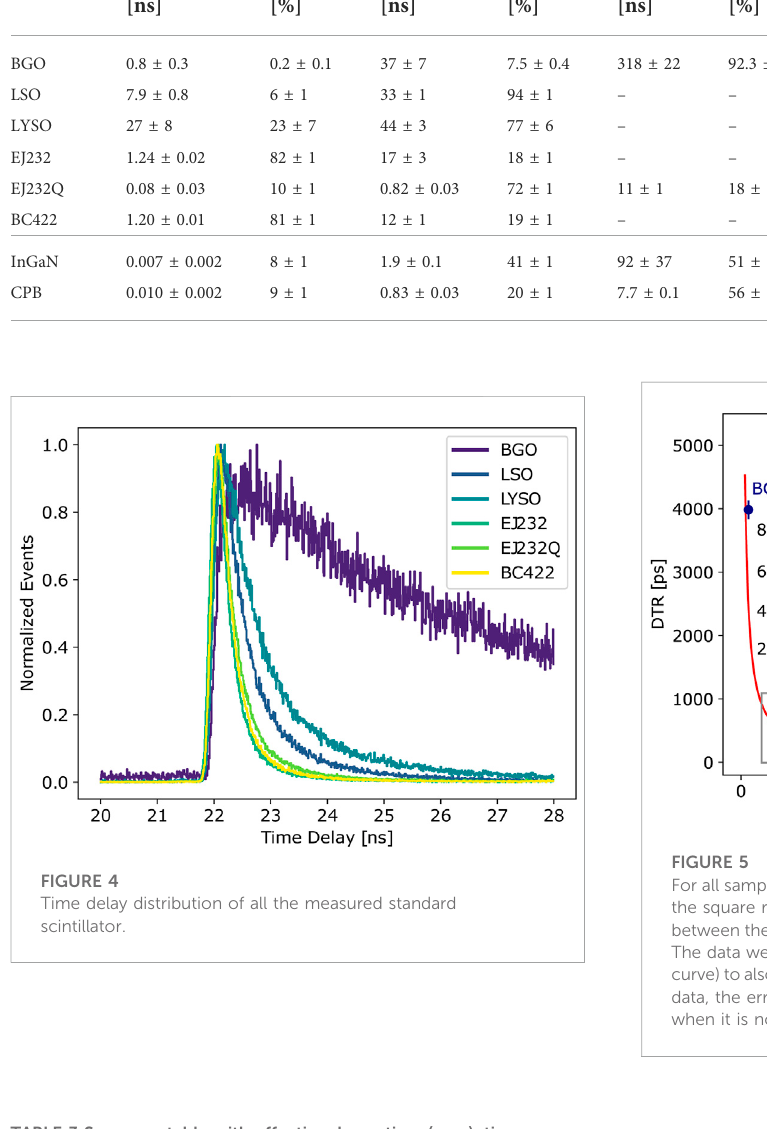
TABLE 3 Summary table with effective decay time ( τ d ,eff ), time resolution at FWHM (DTR), and light output (LO), de fi ned as the mean of the collected charge distribution.